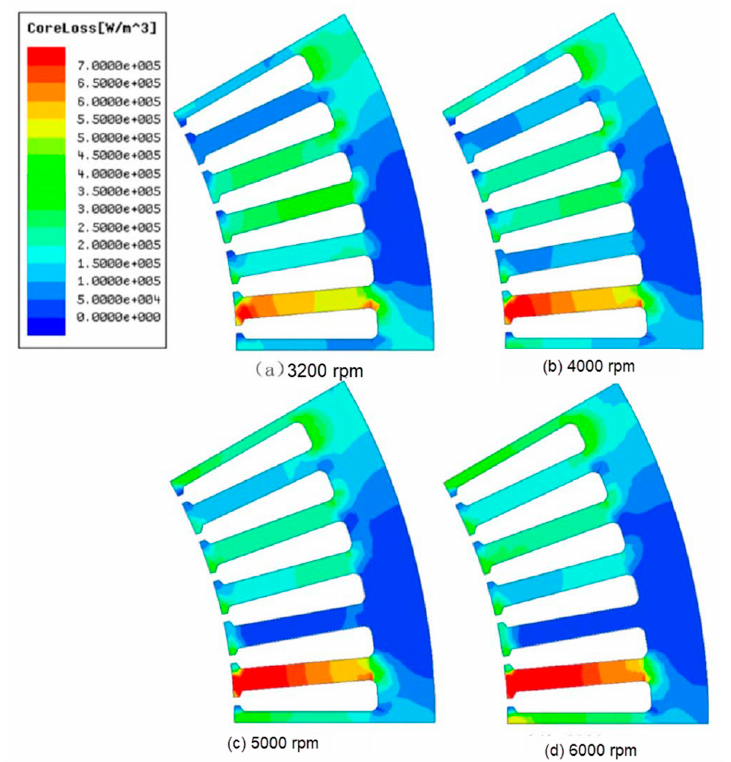
Figure 19. Cloud diagram of load core loss at different speeds.